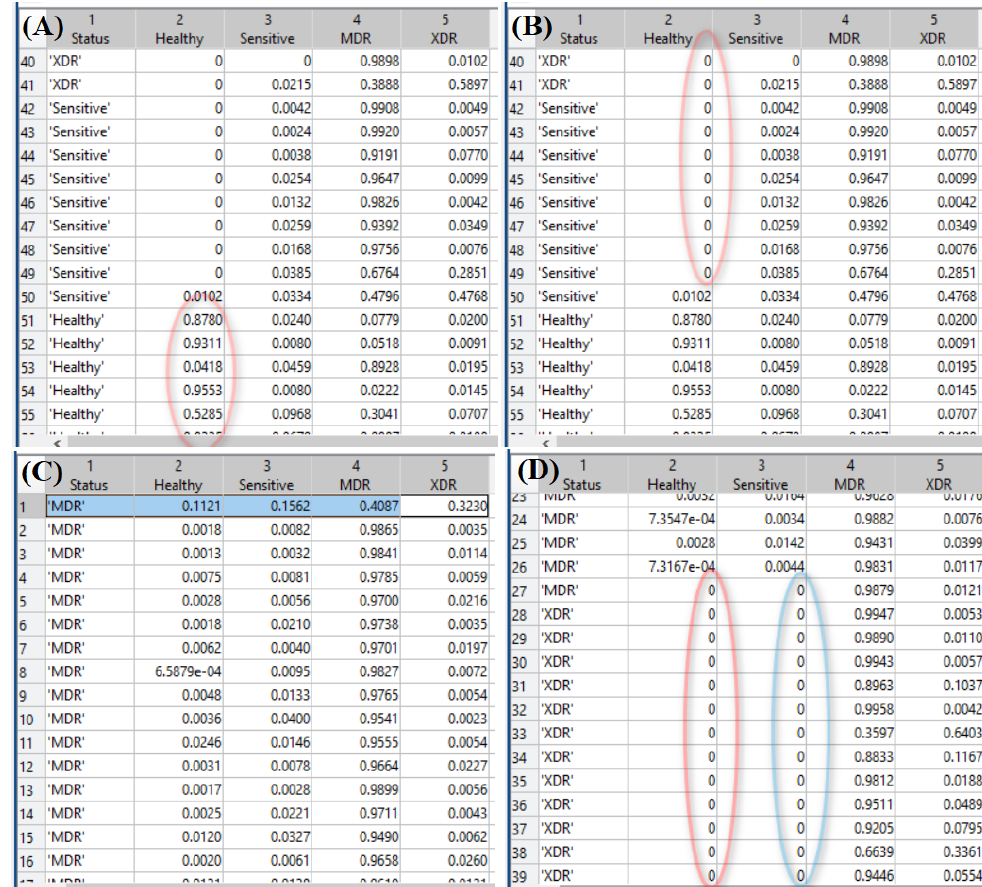
Figure 3. Examples from the table reporting probabilities assigned by the C AT B OOST multiclassifier with special highlighting of the maximal probabilities of the healthy status for the sample of healthy persons ( A ), zero probability of the “Healthy” status for persons suffering from MtB sensitivity to conventional drugs ( B ), no zero probability for multidrug-resistant case ( C ), and zero probability for persons suffering from extra drug-resistant MtB ( D